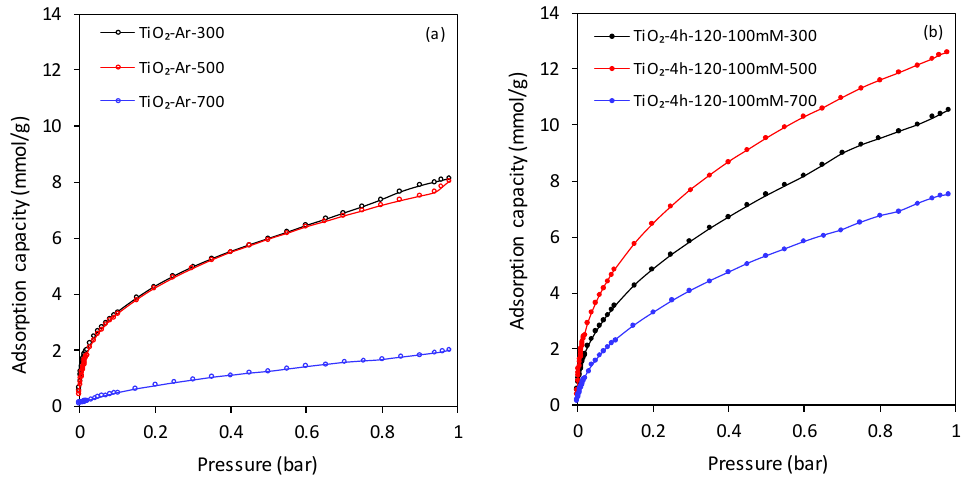
Figure 5. CO 2 adsorption capacity recorded at 0 °C of ( a ) unmodified samples and ( b ) samples modified with APTES calcined at various temperatures.